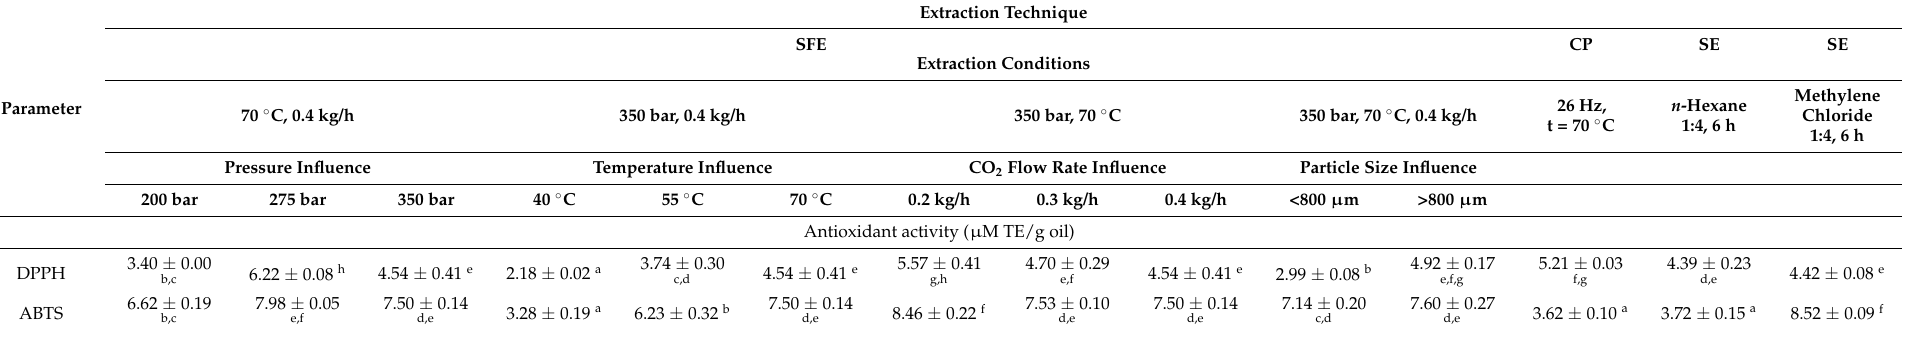
Table 5. Antioxidant activity of cherry seed oils recovered by different extraction